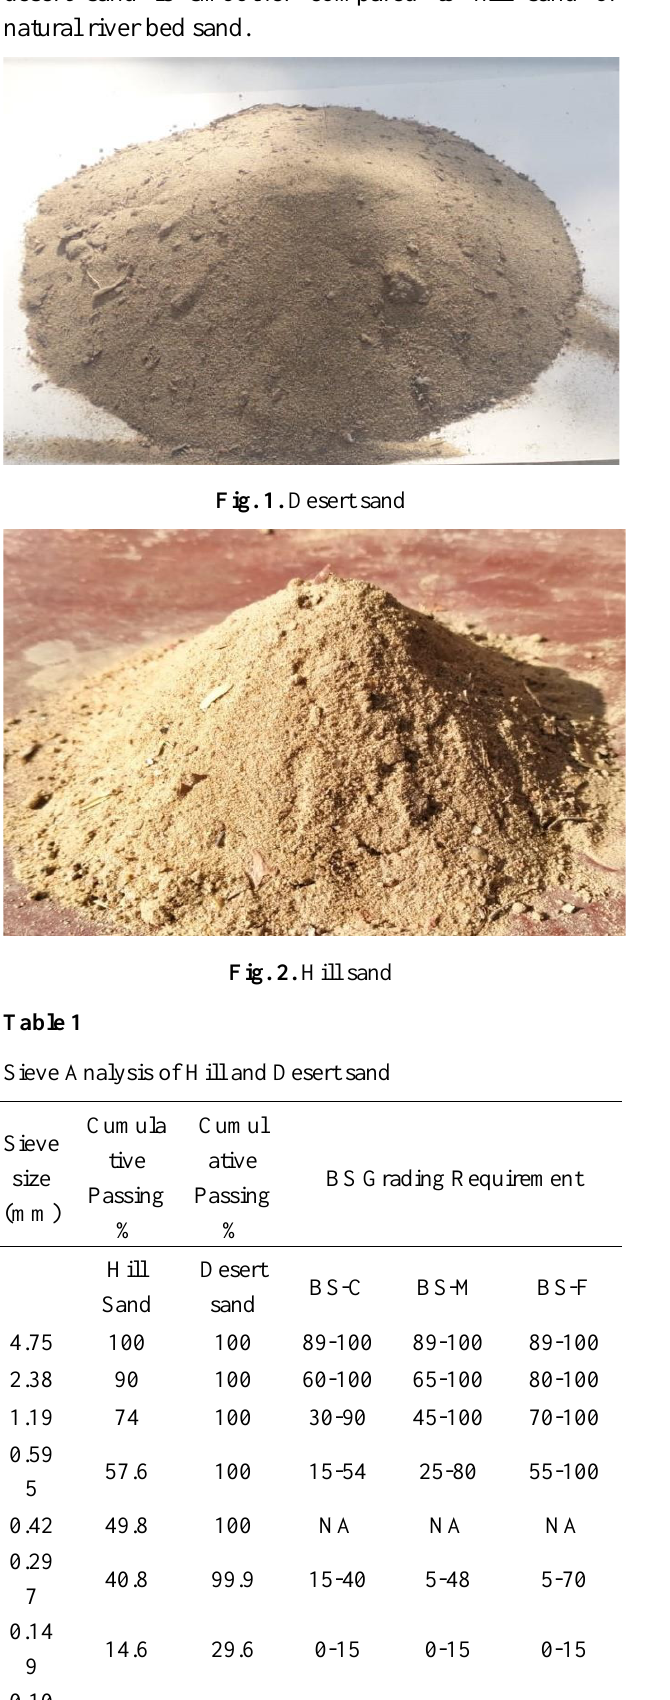
Fig. 5. Comparison of hill and desert sand